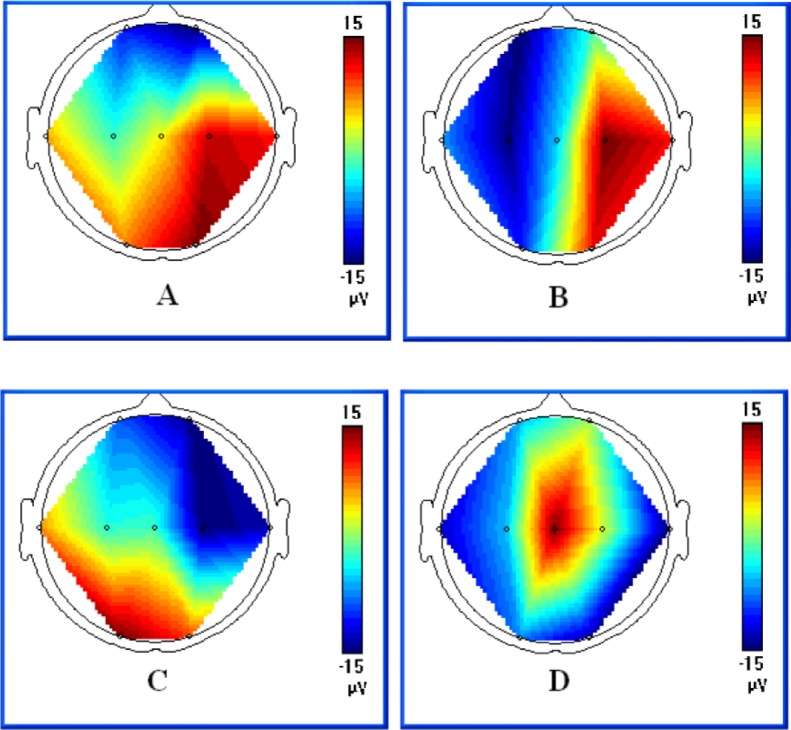
Amplitude distribution charts of the same seizure in Fig 1.The charts show the amplitude changes of the recording area which indicates the highest to lowest amplitude with red to blue gradient color scale. A displayed the highest amplitude distribution on bilateral occipital and right temporal lobes as the initial of the seizure (O1, O2, T4, corresponding to A of Fig 1); B showed a migration to the right hemisphere emphasized on occipital and temporal lobes (O2, T4, corresponding to B of Fig 1); C indicated left occipital dominated again (O1, corresponding to C of Fig 1); Both temporal gained the lowest amplitude when the seizure ended (corresponding to D in Fig 1) in D.